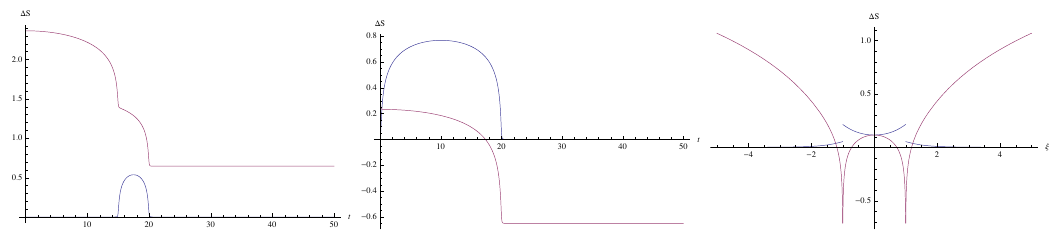
at (cid:11) = 0 : 1. We A